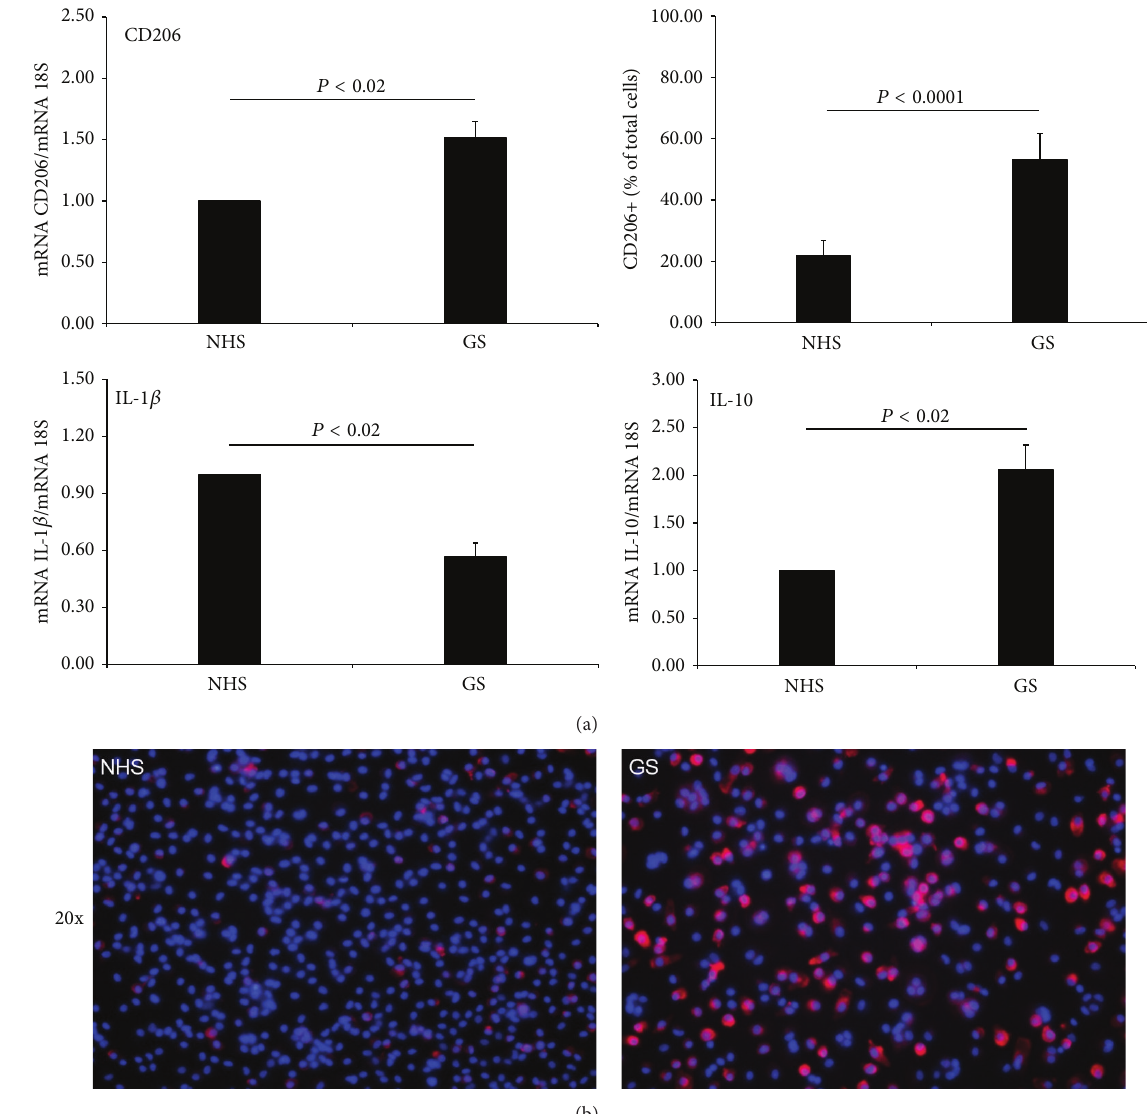
Figure 3: Human macrophages conditioned for 24 hours with gravid serum (GS) downregulate the expression of IL-1 𝛽 and upregulate IL-10. Increased expression of CD206 was observed at gene and protein level. (a) mRNA expression levels of IL-1 𝛽 , IL-10, and CD206 were measured by qPCR and normalized to those of the human housekeeping gene 18S. Results were expressed as AUs, in which 1AU represents the value obtainedwithmacrophagesculturedinNHSusedasapositivecontrol.TheamountofCD206positivemacrophageswasevaluatedbycounting labeled cells using ImageJ (NIH, United States), considering a percentage of positive cells in at least 5 different fields. Bars represent the mean ± S.E.M. of at least 3 independent experiments. ∗ 𝑃 < 0.02 and ∗∗∗ 𝑃 < 0.0001 (Mann-Whitney test). (b) Immunofluorescence reveals the upregulation of the expression of CD206 protein (red) in human macrophages cultured for 24 hours in presence of GS. DAPI nuclear staining is shown in blue. Images were acquired with Leica DM3000 microscope. Original magnification